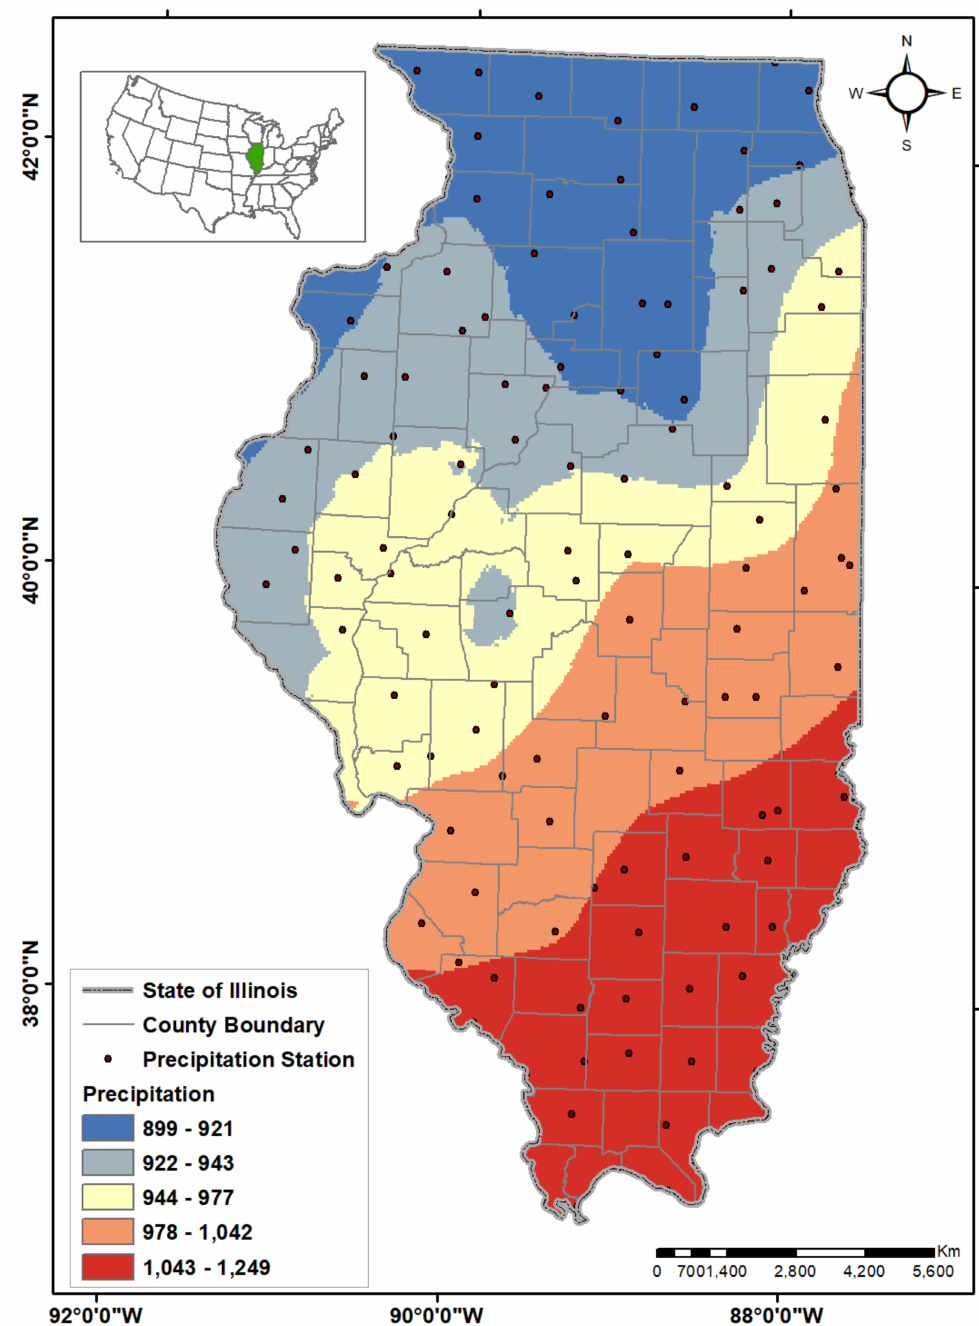
Figure 1. Location map showing the distribution of precipitation stations within the state of Illinois. The map also shows an interpolated distribution of long-term annual precipitation across the state. The heat-map represents the quantiles in rainfall at equal